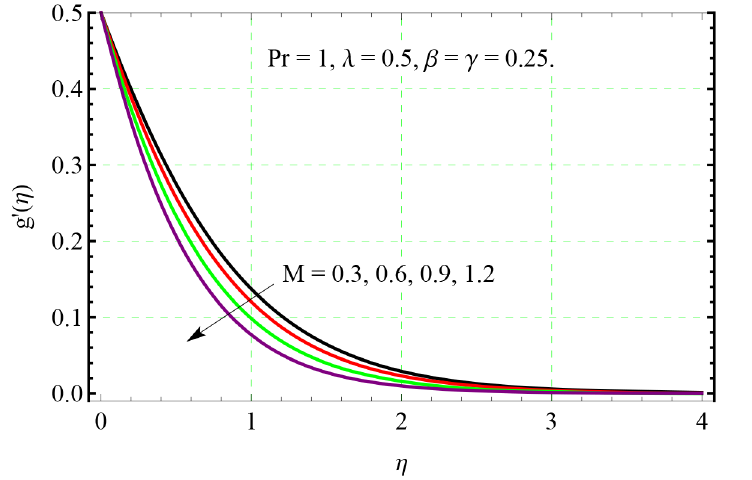
Fig 8. Effect of M on g 0 ( η